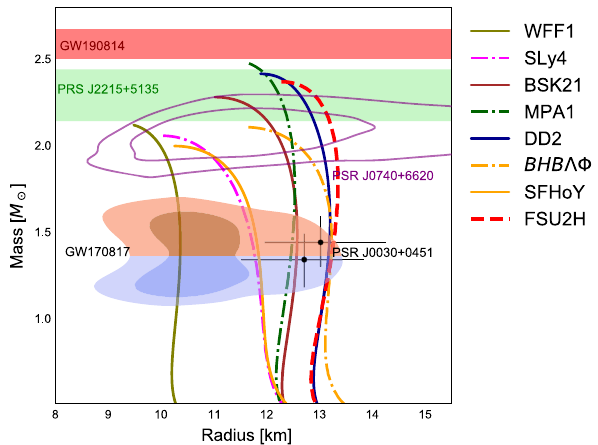
Fig. 1 The mass–radius diagram of neutron stars in GR for the dif- ferent EoSs. The blue and orange regions are the mass–radius con- straints from the GW170817 event. The purple region represents the pulsar J0740+6620 and the light green region amounts to the pulsar J2215+5135 and also the black dots with error bars, are the NICER esti- mations of PSR J0030+0451. The mass of the compact object observed by the GW190414 event is shown as a red band